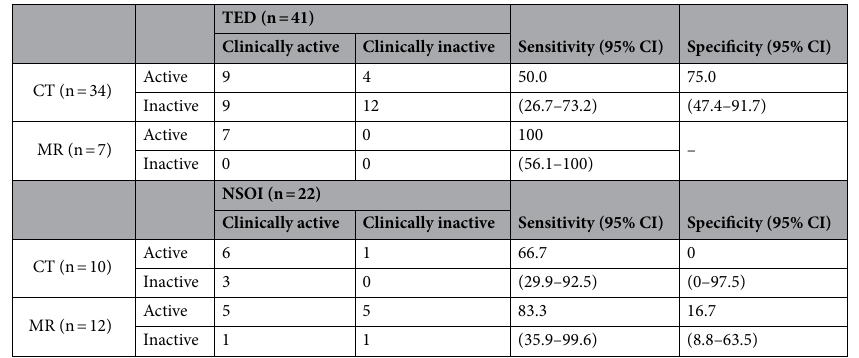
Table 3. Sensitivity and specificity of the imaging study for assessment of inflammation activity in TED and NSOI. TED thyroid eye disease, NSOI non-specific orbital